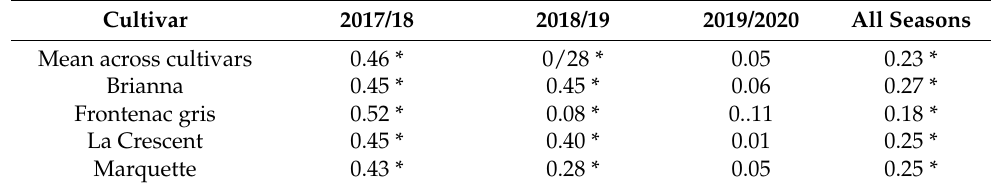
Table 1. Pearson correlation coefficient between cultivar low temperature exotherms and mean seven- day minimum temperature prior to sampling in 2017/18, 2018/19, and 2019/20 winter seasons.